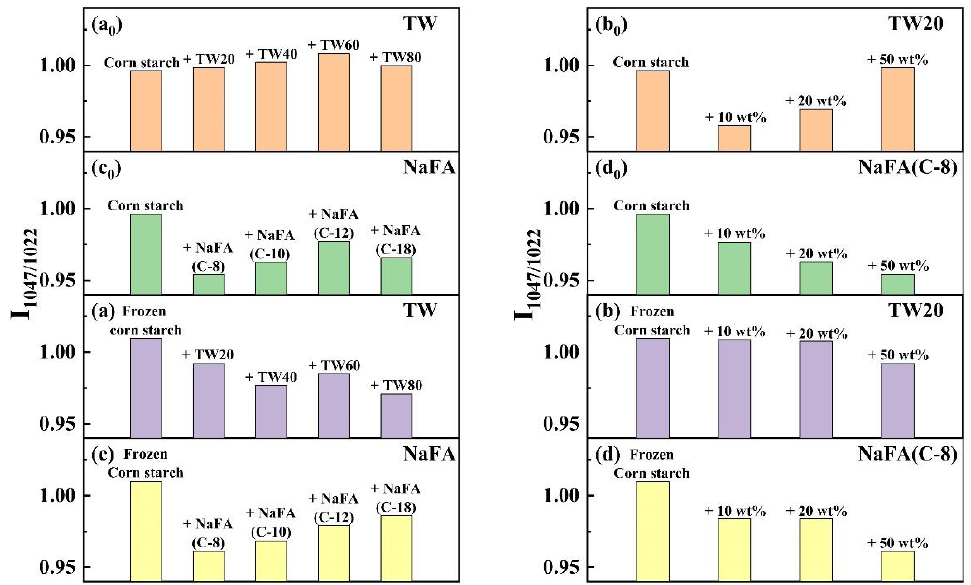
Figure 5. Change of band intensity ratios of regular or frozen corn starch at 1047 cm −1 and 1022 cm −1 (I 1047 / 1022 ) in the presence of Tween (TW) and sodium fatty acid (NaFA). ( a 0 , a ) I 1047 / 1022 of regular or frozen corn starch in the presence of TW (50 wt%). ( b 0 , b ) I 1047 / 1022 of regular or frozen corn starch in the presence of different concentrations of TW20. ( c 0 , c ) I 1047 / 1022 of regular or frozen corn starch in the presence of NaFA (50 wt%). ( d 0 , d ) I 1047 / 1022 of regular or frozen corn starch in the presence of different concentration of NaFA (C-8).